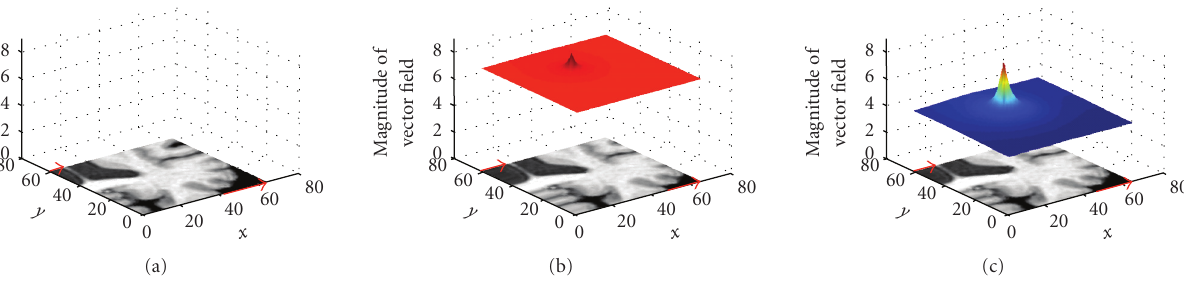
Figure 6: 2D demonstration of the vector field interpolation around a small cluster of displacement vectors. (a) Image before. (b) Deformed image and corresponding displacement field (magnitude) with high smoothing, hence a large influence zone. (d) Deformed image and corresponding displacement field (magnitude) with low smoothing, which leads to more localized